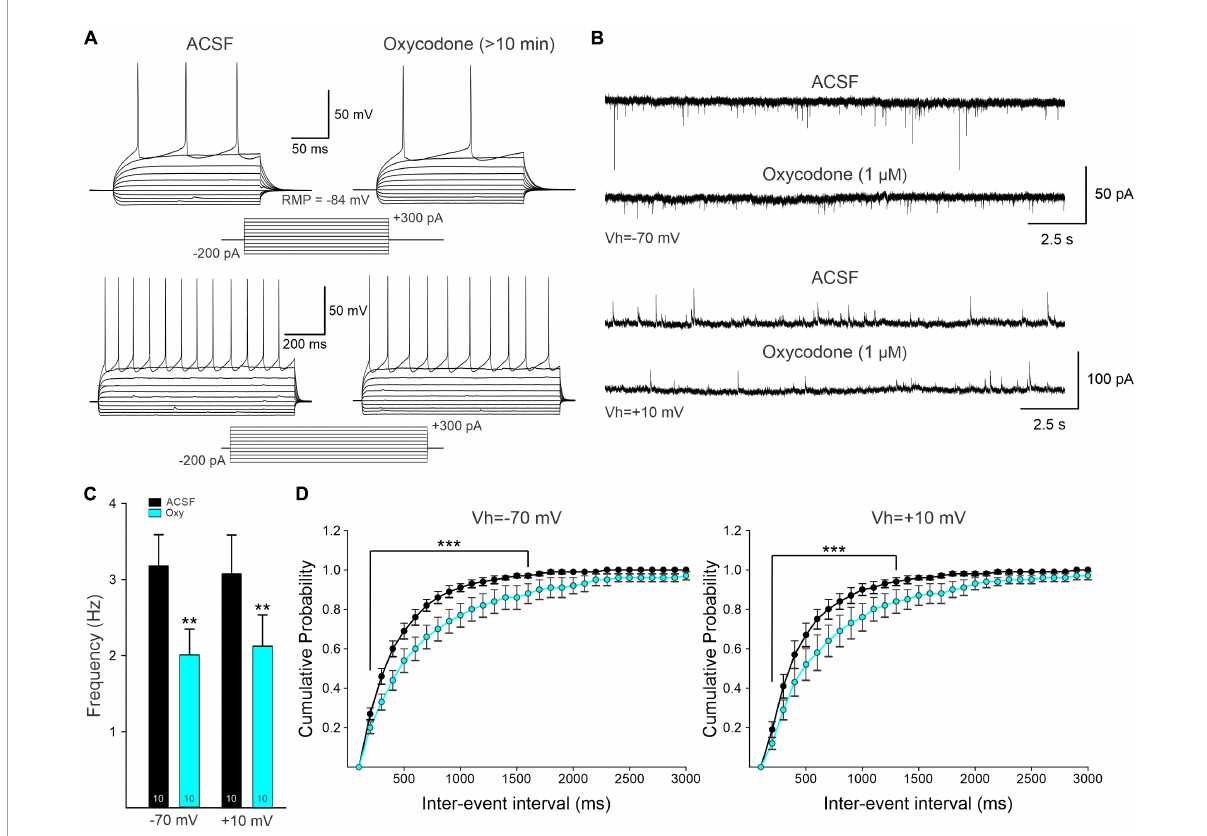
FIGURE6 (A) Representative electrophysiological recordings of a D1-Cre medium-sized spiny neuron (MSN) in current-clamp mode. Current injections of +300 pA (250 ms duration, upper traces; 1 s duration, lower traces) generated a train of action potentials (APs). Bath application of oxycodone decreased the frequency of evoked APs. (B) Whole-cell patch clamp recordings from intact mice not used for Miniscope recordings. Spontaneous postsynaptic currents of MSNs held at -70 and +10 mV to electrophysiologically isolate putative excitatory [ α -amino-3-hydroxy-5-methyl-4-isoxazolepropionic acid (AMPA) receptor-mediated] and inhibitory (GABA A receptor-mediated) synaptic currents. Ten min after oxycodone bath application, spontaneous synaptic activity was reduced. This reduction is likely the result of presynaptic inhibition of neurotransmitter release. (C) Average frequency of spontaneous synaptic currents recorded at -70 mV and +10 mV. Numbers within the bar graphs indicate the number of neurons recorded. In both conditions, there was a statistically significant reduction in